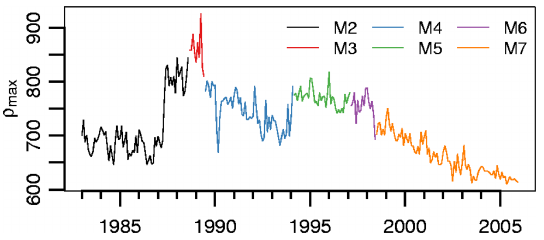
Figure 4. Temporal evolution of the 95th percentile ( ρ max ) of the observed reflections for MVIRI, covering 1983 to 2005. The differ- ent MVIRI instruments (M2–M7) are coloured for a better distinc- tion. Image from Posselt et al.